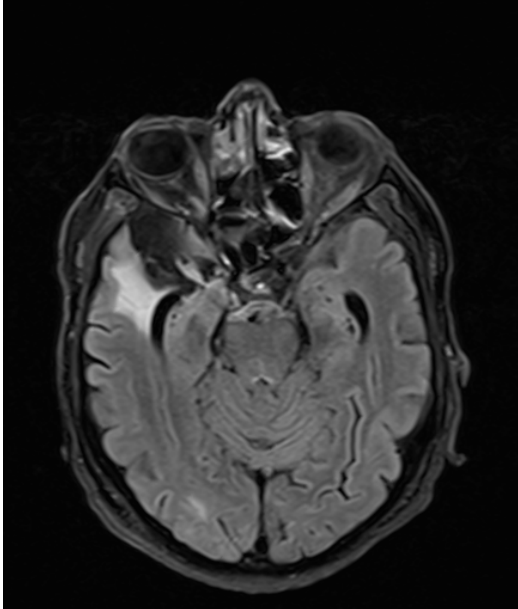
Figure 2. FLAIR cranial MRI image of the parenchymal defect in the right frontobasal region as a result of subarachnoid hemorrhage.